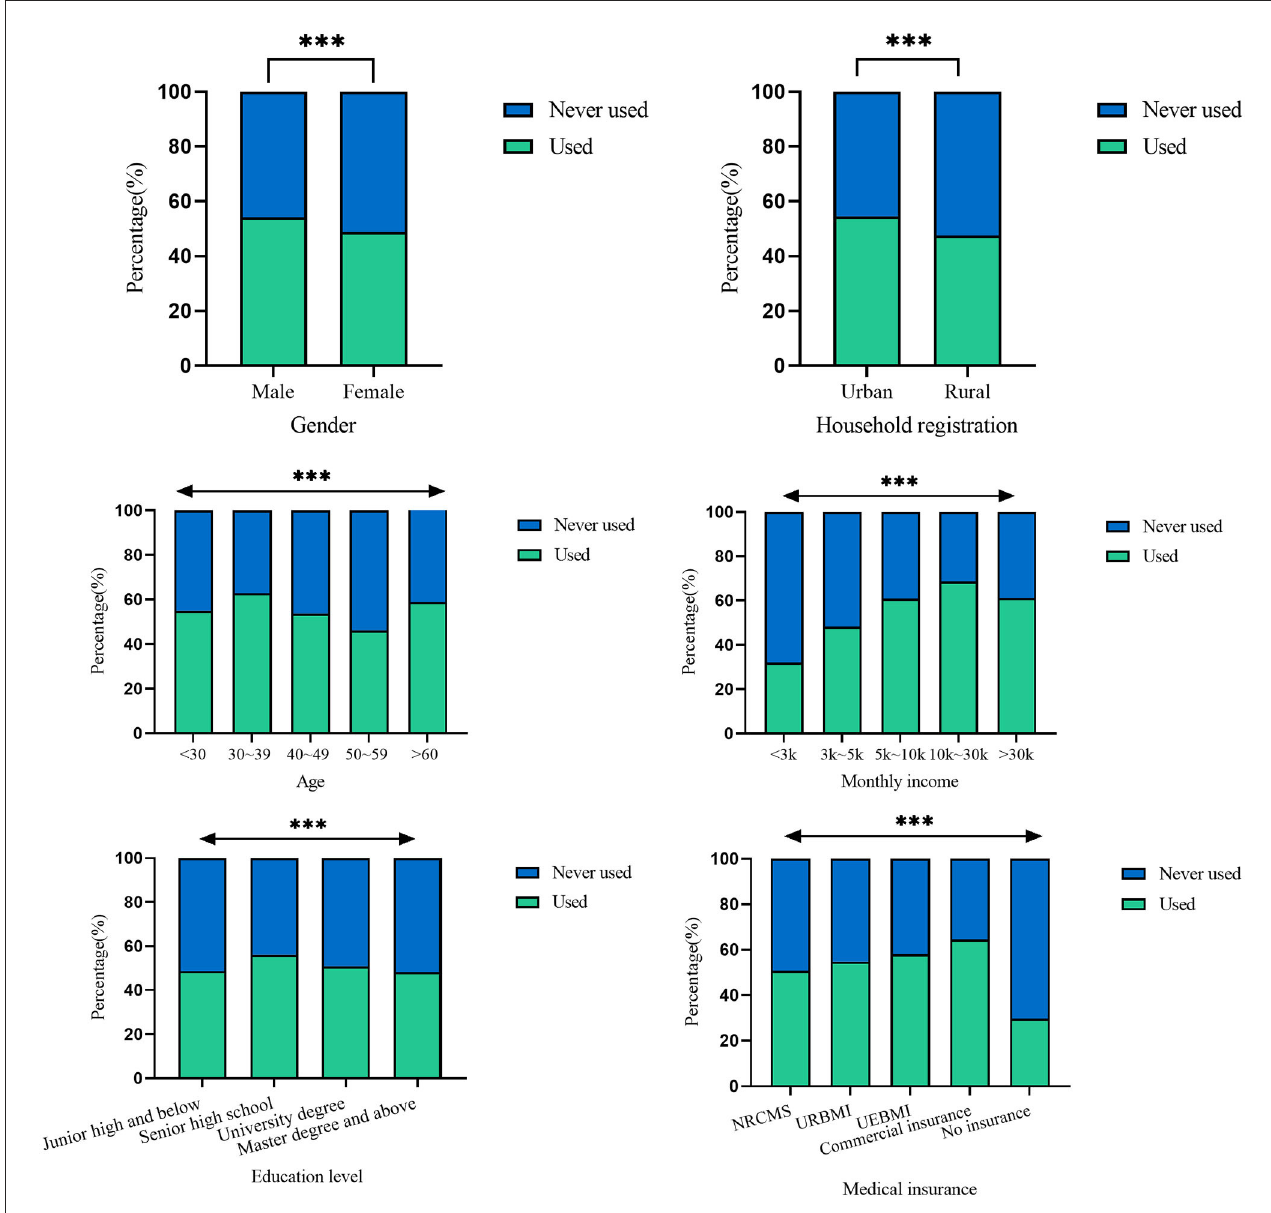
FIGURE1 Use of Internet-based healthcare services provided by primary health institutions. *** p -value < 0.001.